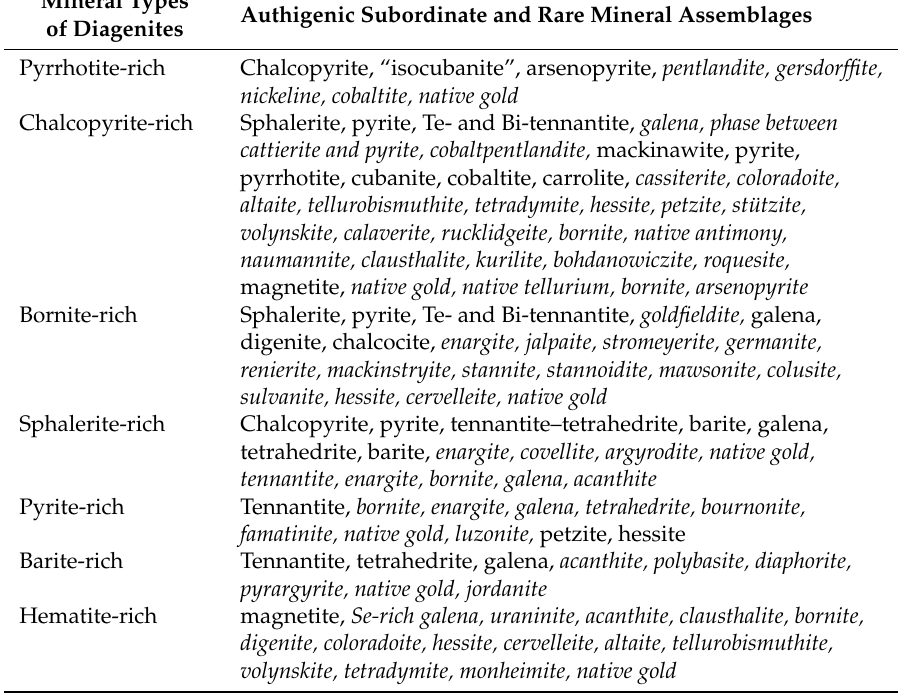
Table 2. Typical authigenic minerals of ore diagenites of the Urals VHMS